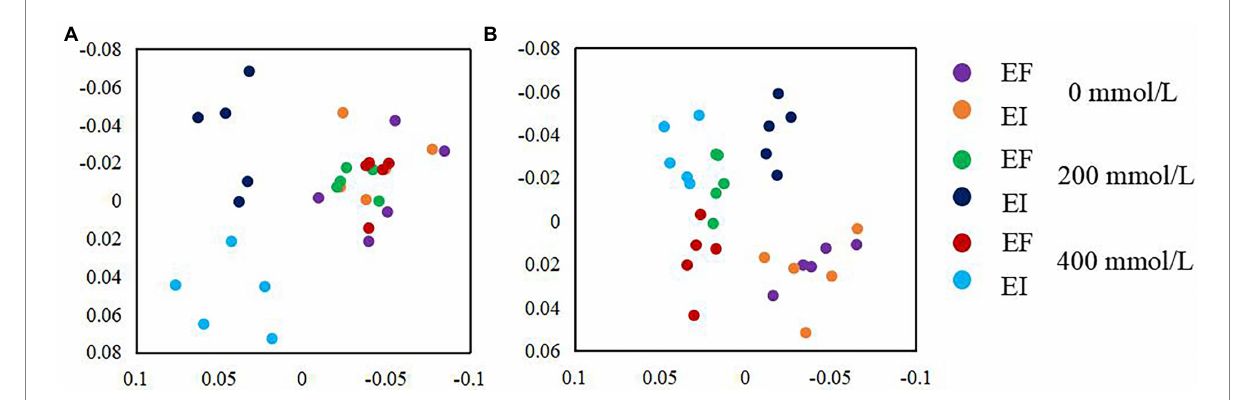
FIGURE 4 Non-metric multidimensional scaling (NMDS) ordination of PSF (A) and PSB (B) community composition in roots of tall fescue with (EI) and without (EF) Epichloë endophyte under saline-alkali